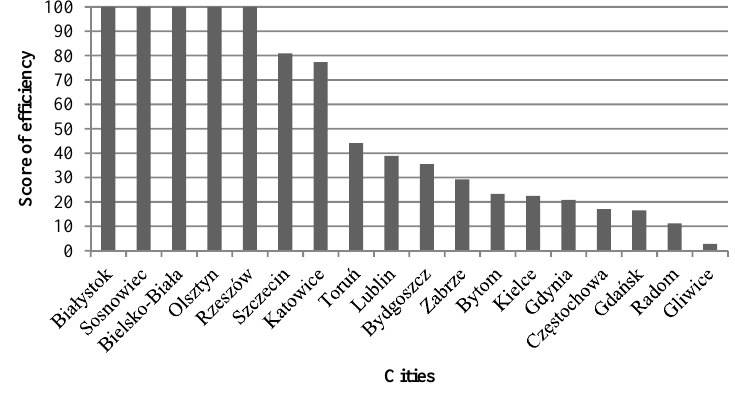
Figure 2. Technological efficiency of urban transport